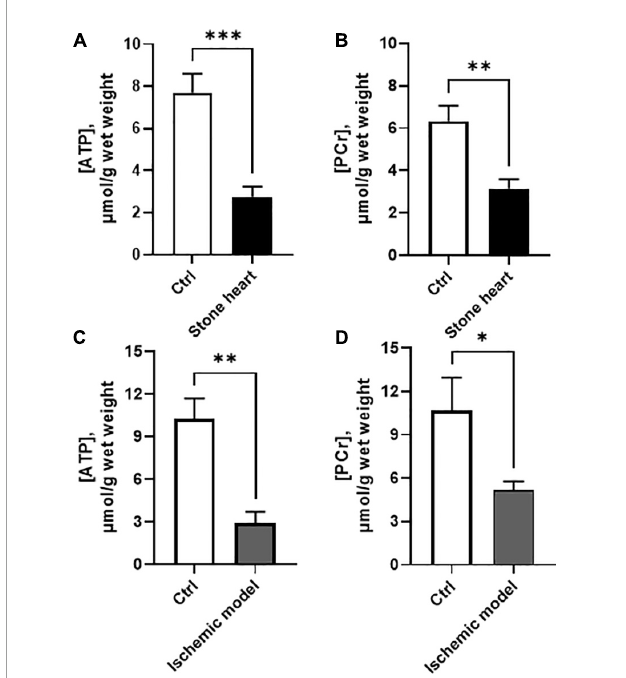
FIGURE4 ATP and PCr contents in samples taken from the hearts of anesthetized pigs (A,B) and trabeculae in vitro (C,D) . Controls (beating hearts or oxygenated trabecular preparations) are shown with open bars, and stone heart/ischemia in vitro with filled bars. N = 3–10 in each group (from two to four animals in each group). ∗ p < 0.05; ∗∗ p < 0.01; ∗∗∗ p <